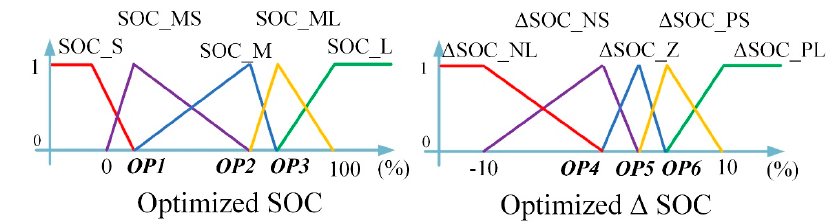
Figure 7. Illustration for optimized input MFs.